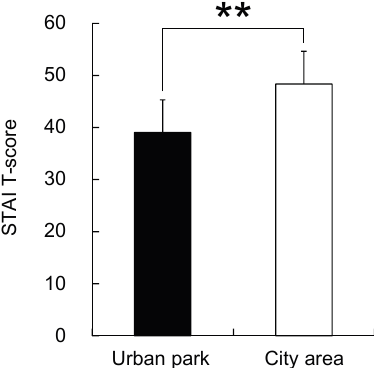
Figure 8. Comparison of subjective State-Trait Anxiety Inventory (STAI) scores between the two environments. N = 23, mean ± standard deviation. ** p < 0.01, determined by the Wilcoxon signed-rank test (one